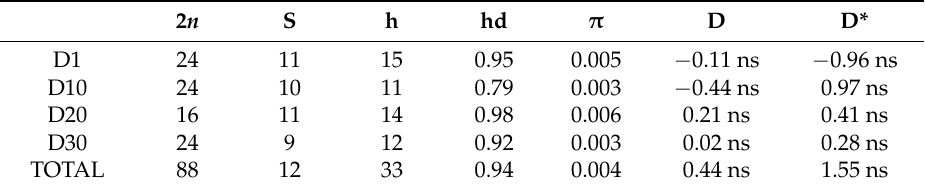
Table 4. Genetic diversity parameters of GSTe2 sequences according to the age of mosquitoes and the L119F